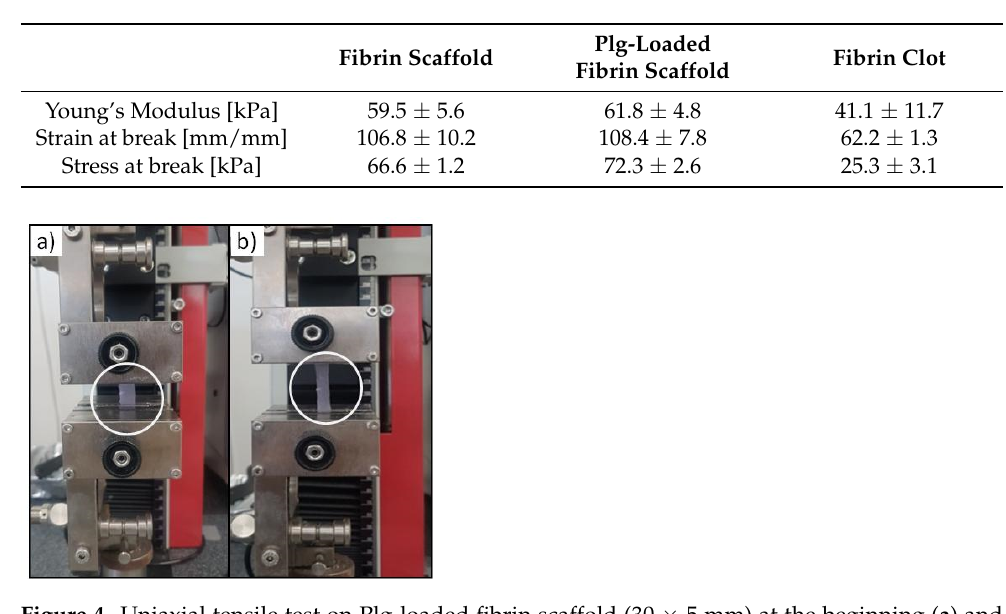
Figure 3. SEM images ( A , B ) of the exposed side and ( C , D ) of the side in contact with the mandrel